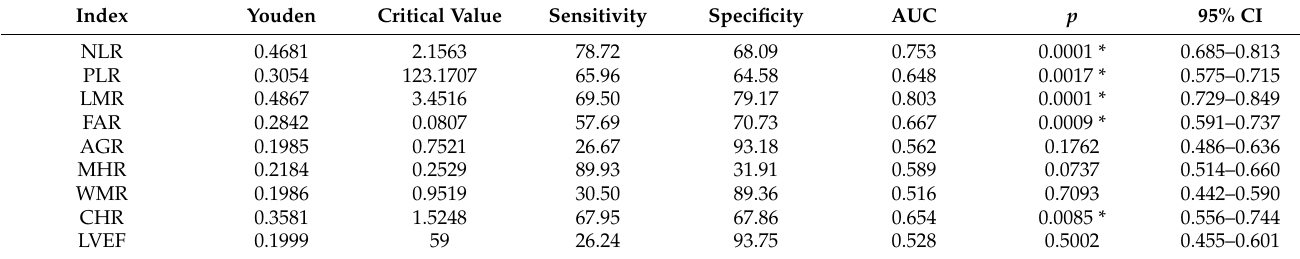
Table 7. ROC curve analysis of SII for diagnosis of